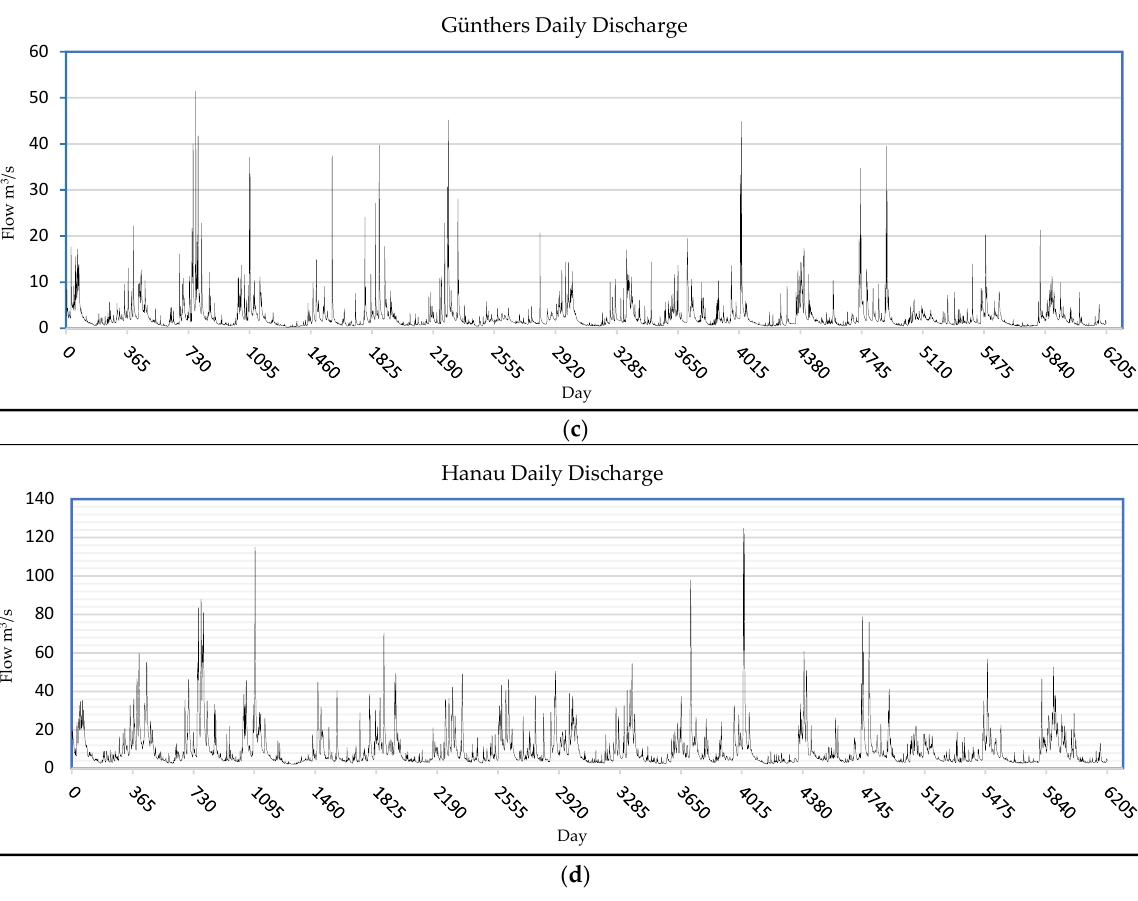
Figure 2. ( a ) Daily discharge of Biedenkopf; ( b ) daily discharge of Ehringen; ( c ) daily discharge of Günthers; ( d ) daily discharge of Hanau; time scale refers to the period from 2000 to 2017. Table 1. Summary of descriptive statistics of daily discharge for four stations.